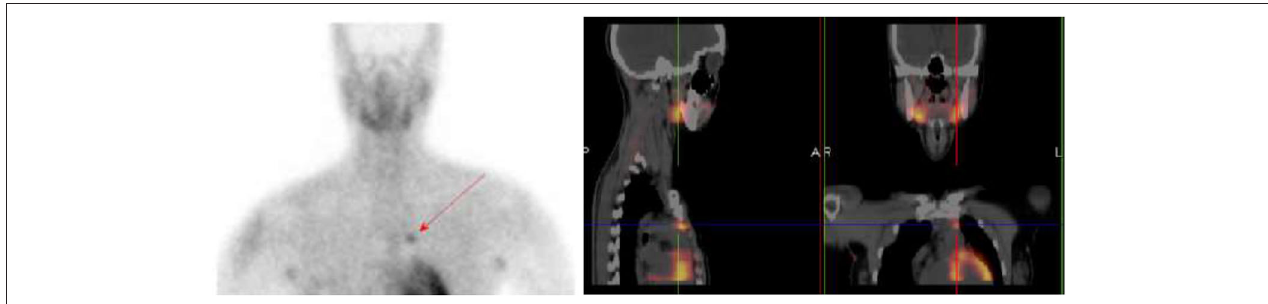
FIGURE 1 | Sesta-MIBI parathyroid scan combined with SPECT-CT study of the neck-mediastinum showing the anterior mediastinal parathyroid adenoma.